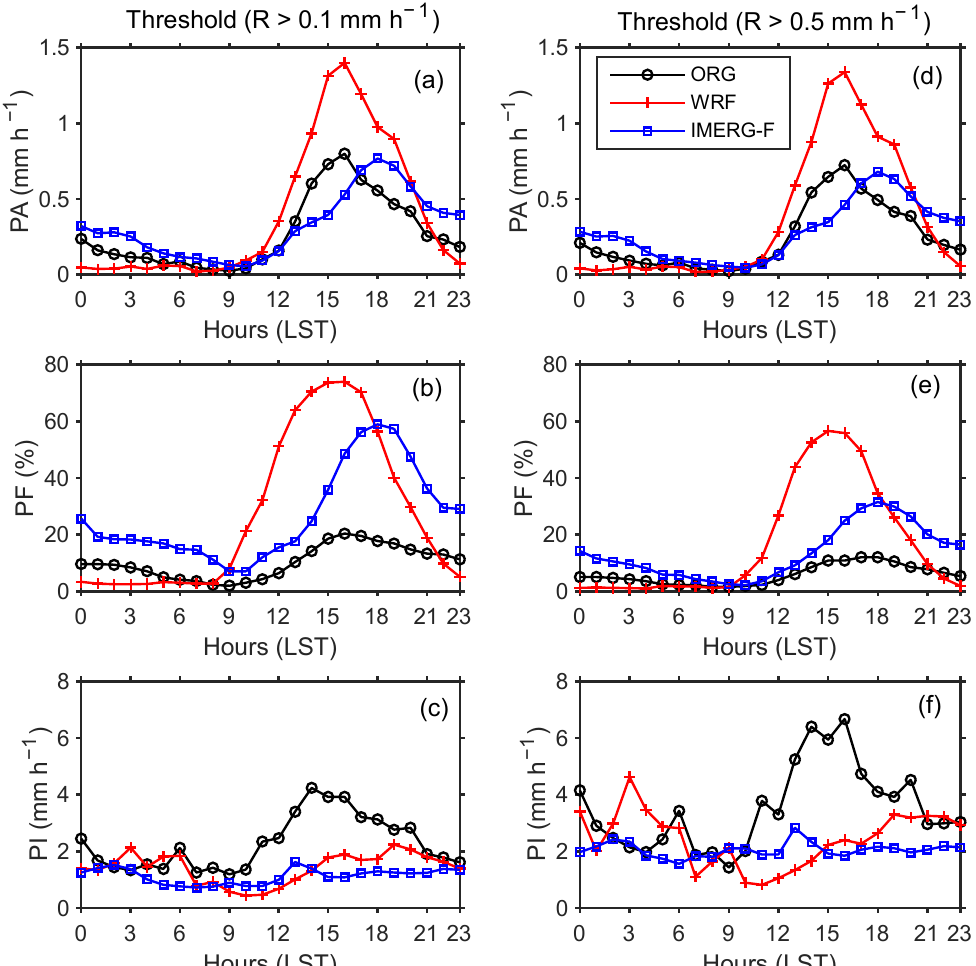
Figure 10. Comparison of diurnal variation of PA, PF, and PI from ORG with the WRF model and IMER-F data during 2013–2015. Calculations used two rainfall rate ( R ) thresholds: R > 0.1 mm h −1 ( a−c ) and R > 0.5 mm h −1 ( d−f ).